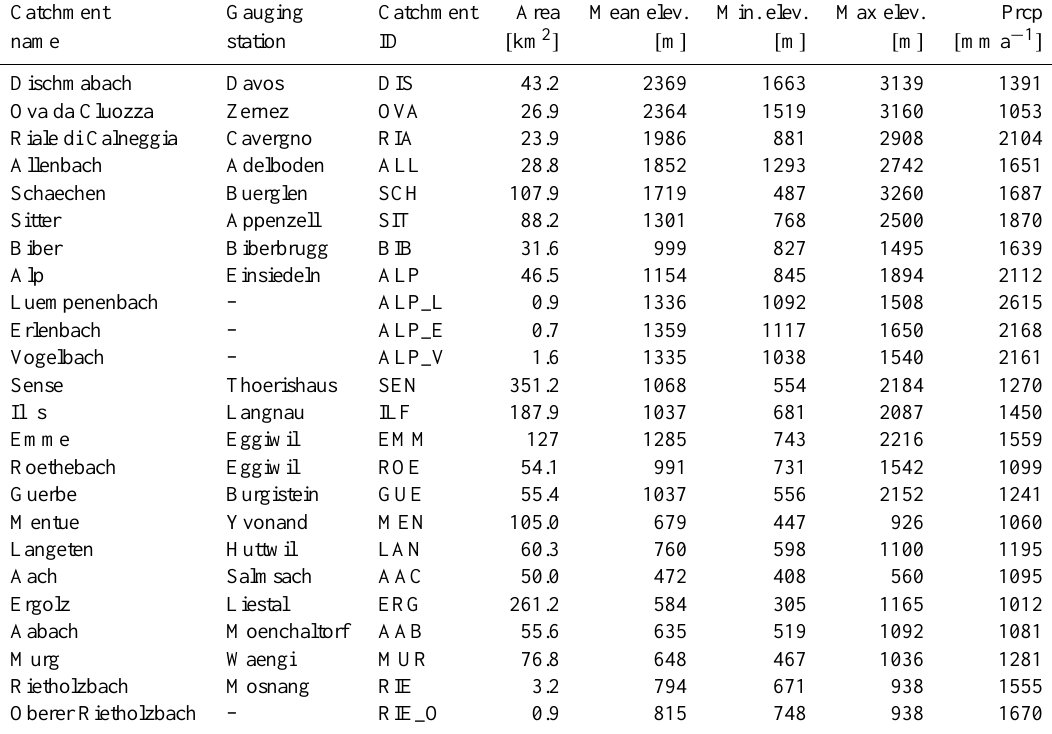
Table 1. Areas, elevations and mean annual precipitation sums of the 24 studied catchments. Catchment Gauging Catchment Area Mean elev. Min. elev. Max elev.